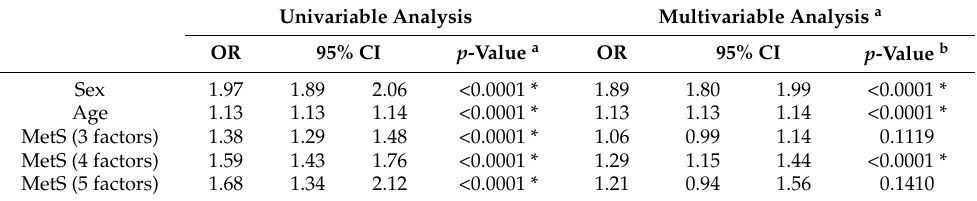
Table 5. Crude and adjusted odds ratios of hearing loss among subjects with metabolic